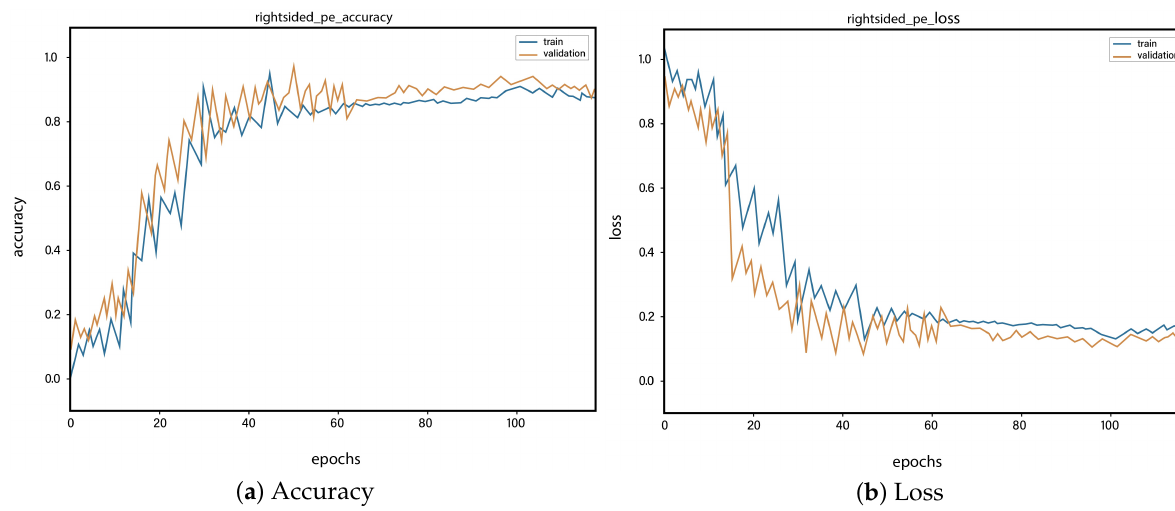
Figure 8. Training vs. validation accuracy and loss for the class: PE present on the image.